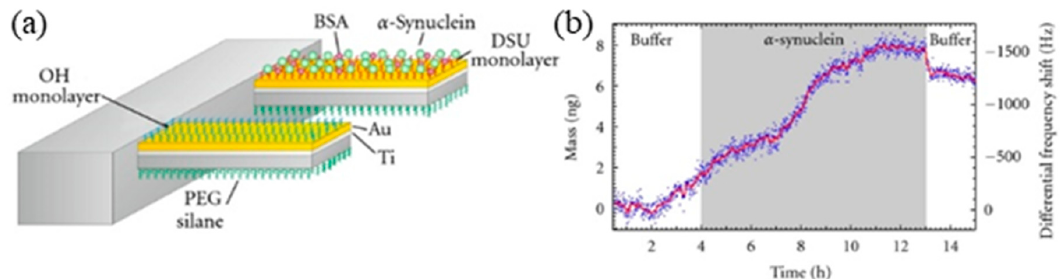
Figure 9. ( a ) Schematic of the functionalized MEMS cantilever for detecting α -synuclein and ( b ) bound mass on the surface of the cantilever and frequency of the cantilever versus time. The left axis shows the bound mass on the cantilever, the right axis shows the corresponding differential frequency shift. The grey area indicates the period that 10 µg/mL α -synuclein in 20 mM sodium phosphate buffer is flowing through the fluidic chamber at a rate of 3.3 µL/min. Reproduced from reference [90] with permission from Hindawi Publishing Corporation.